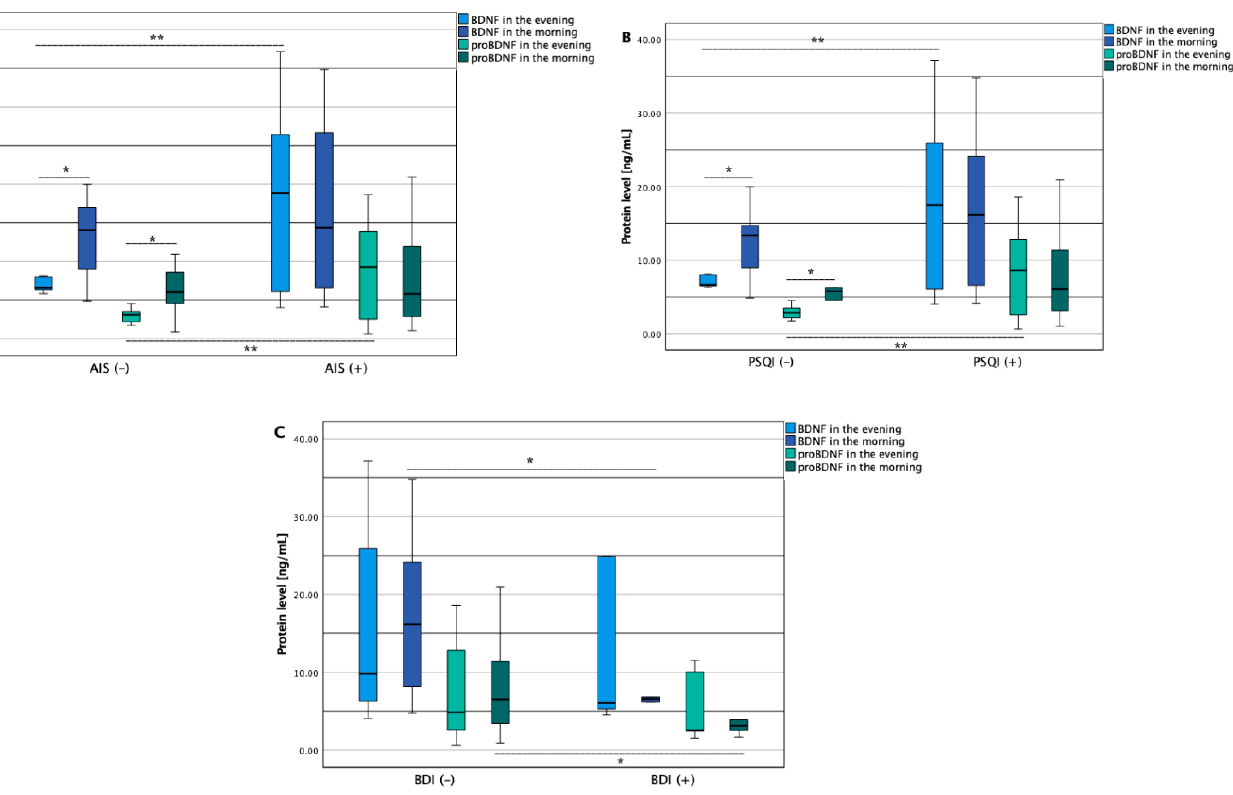
Figure 3. Diurnal and between groups comparisons of BDNF and proBDNF protein levels. AIS— Athens Insomnia Scale; BDI—Beck Depression Inventory; BDNF—brain-derived neurotrophic factor; proBDNF—premature brain-derived neurotrophic factor; PSQI—Pittsburgh Sleep Quality Index; **— p < 0.001; *— p < 0.05. ( A )—comparison of BDNF and proBDNF protein levels between participans with low AIS ( − ) and high AIS (+) scores. ( B )—comparison of BDNF and proBDNF protein levels between participans with low PSQI ( − ) and high PSQI (+) scores. ( C )—comparison of BDNF and proBDNF protein levels between participans with low BDI ( − ) and high BDI (+) scores.